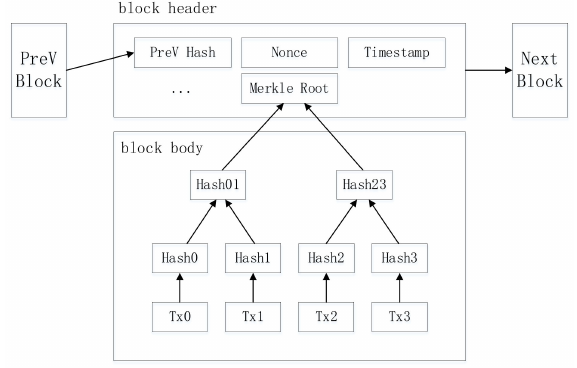
Figure 1. Blockchain block